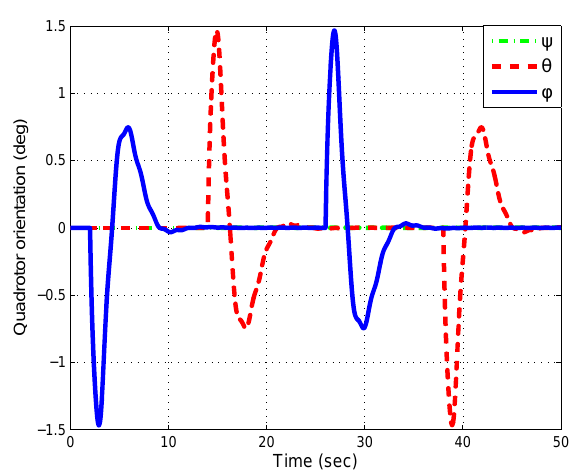
Figure 6. Swing angles.